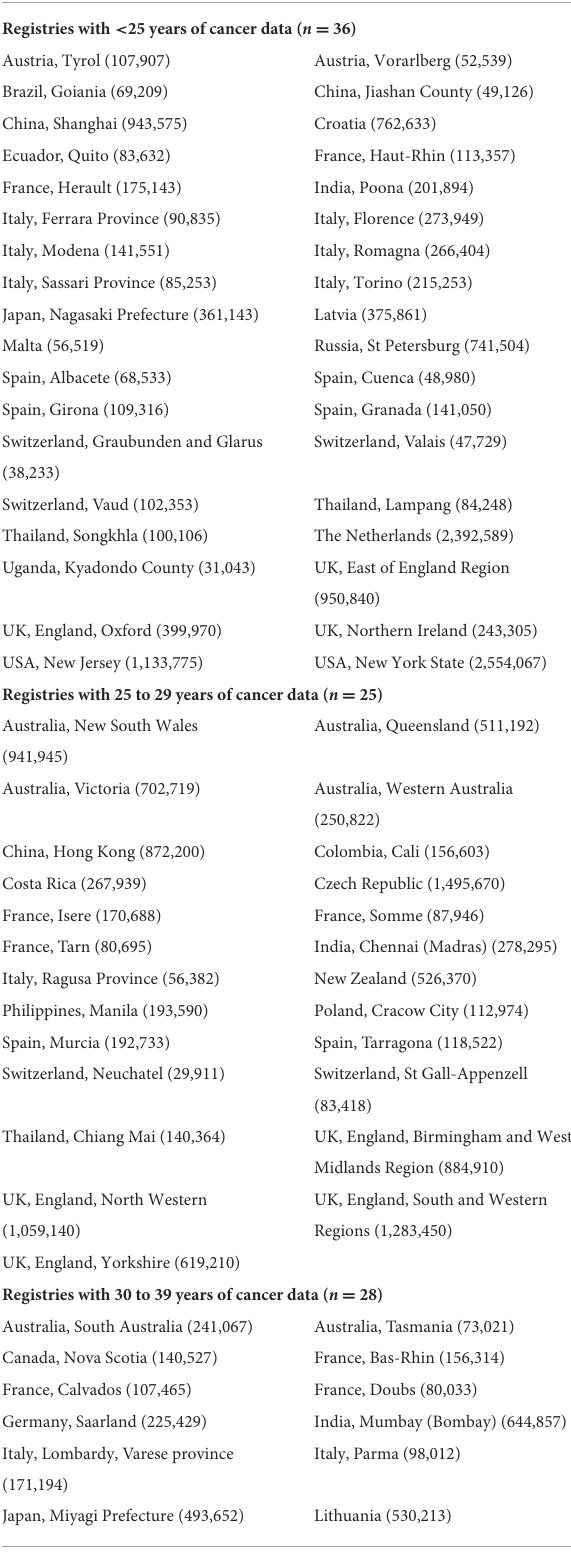
TABLE 1 List of cancer registries from the World Health Organization a .